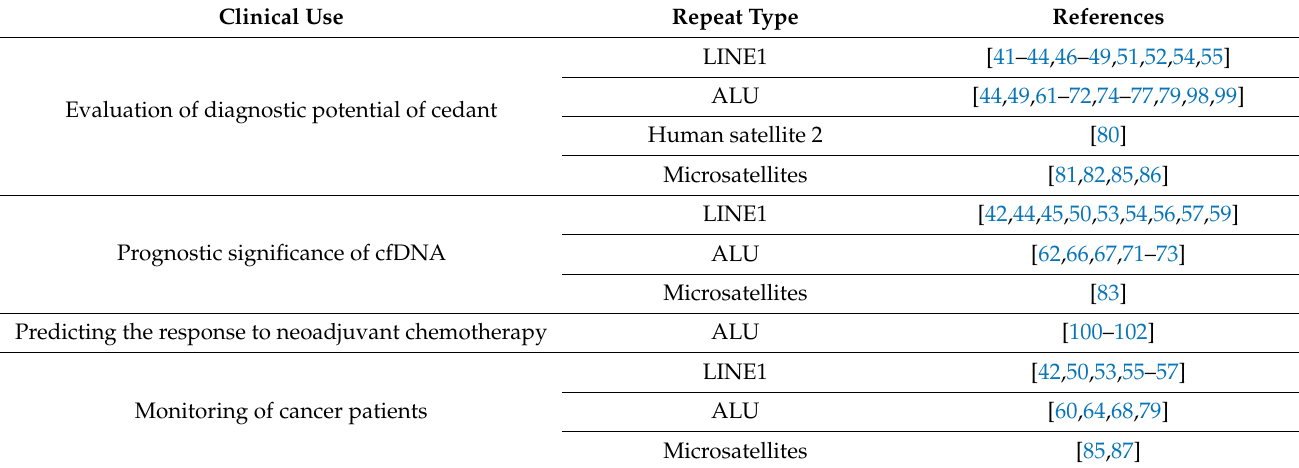
Table 2. Studies that utilized cell-free repetitive DNA in clinical use of cancer